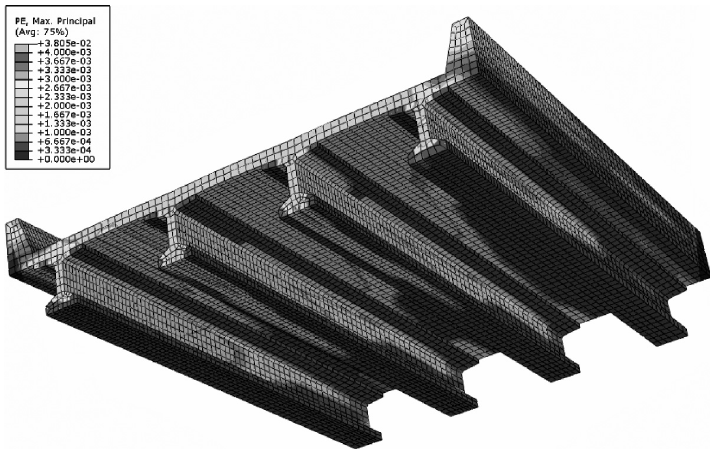
Fig. 28. Maximum principal plastic strain, blast below. Bottom